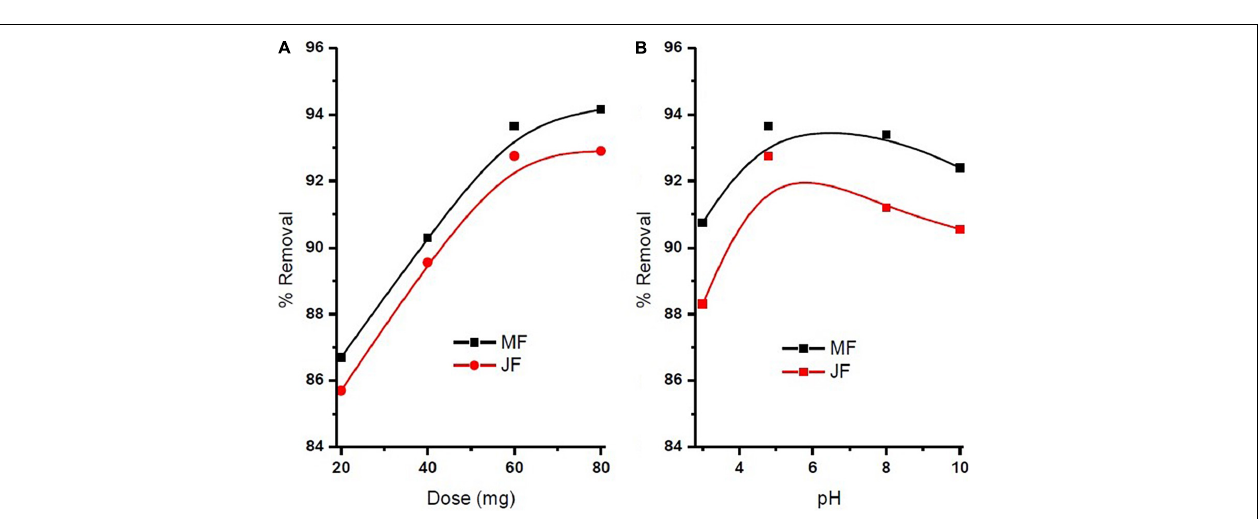
FIGURE 7 | Effect of chromium by using seed bio-sorbent of Mango (M) and Jackfruit (JF): (A) dose and pH of solution and (B) concentration and pH of solution.